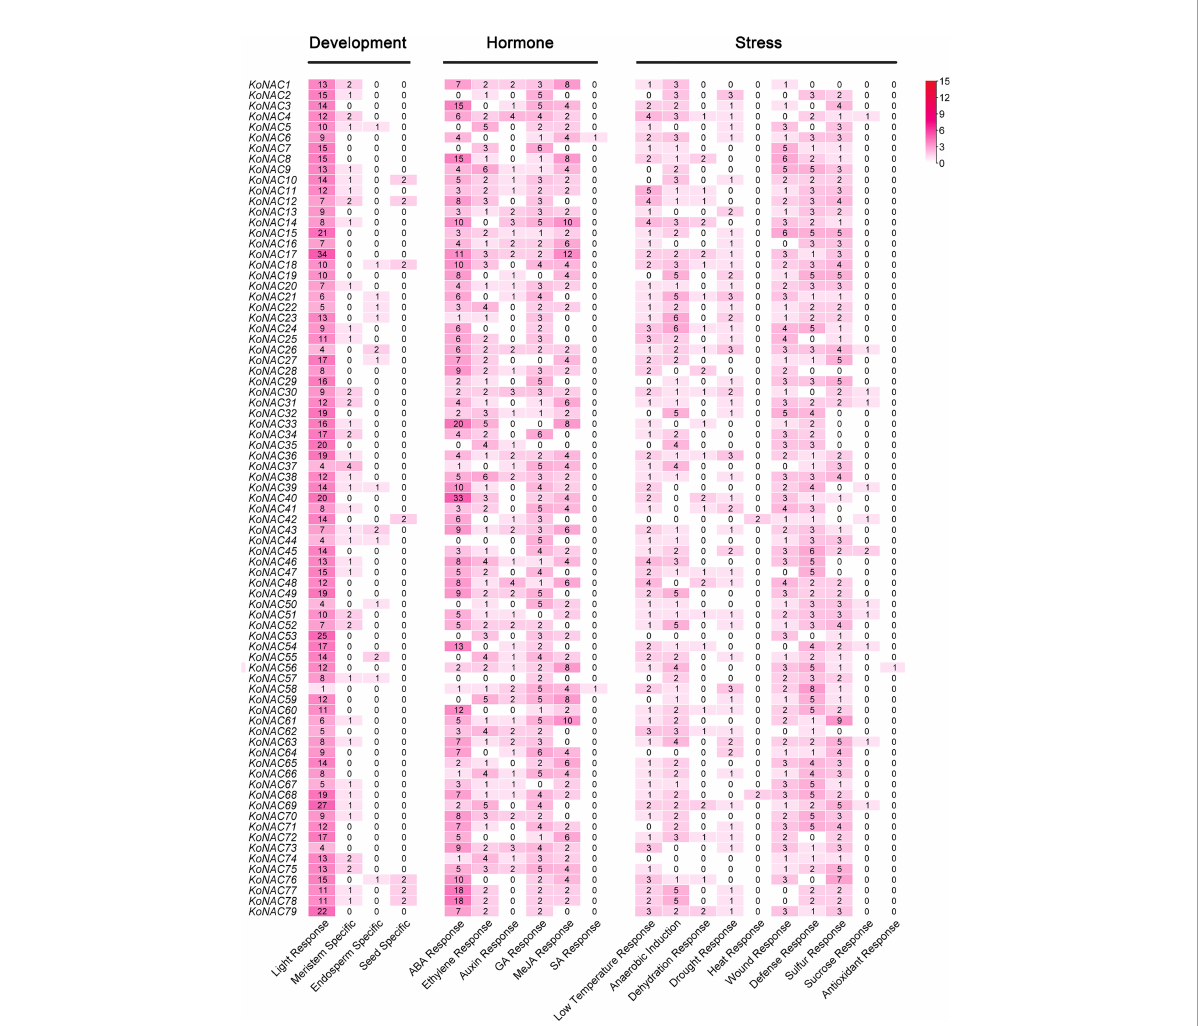
FIGURE 6 The number of each type of cis -acting element in the promoter region of each KoNAC gene. Annotation of the cis -elements: ABA, abscisic acid; GA, gibberellin; MeJA, methyl jasmonate; SA, salicylic